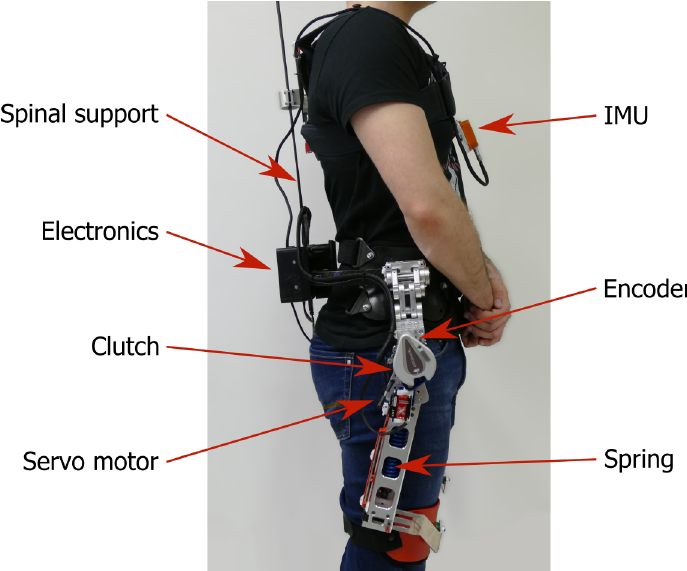
Figure 1. Lateral view of a subject wearing the exoskeleton. Red arrows indicate the locations of key components of the